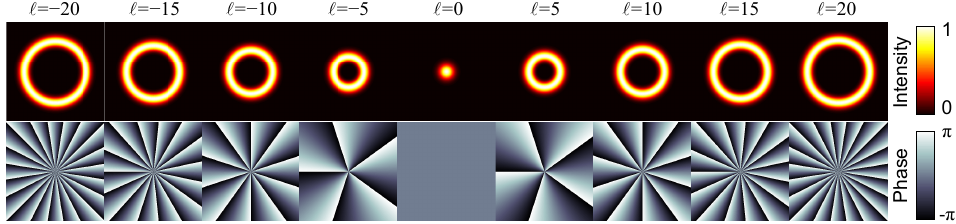
Figure 1. Intensity ( top ) and phase ( bottom ) pattern of LG mode with different TC ( (cid:96) )